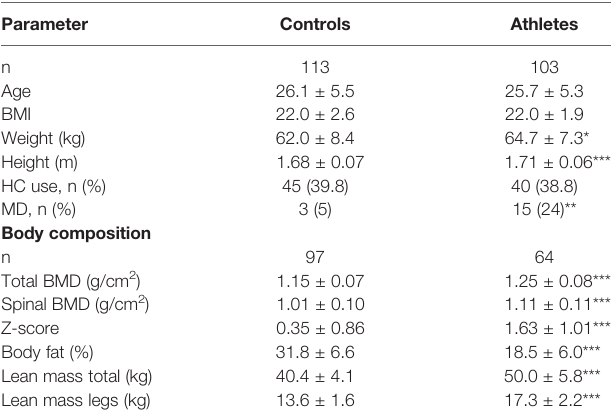
TABLE 2 | General characteristics and body composition in female Olympic athletes and controls. Parameter Controls